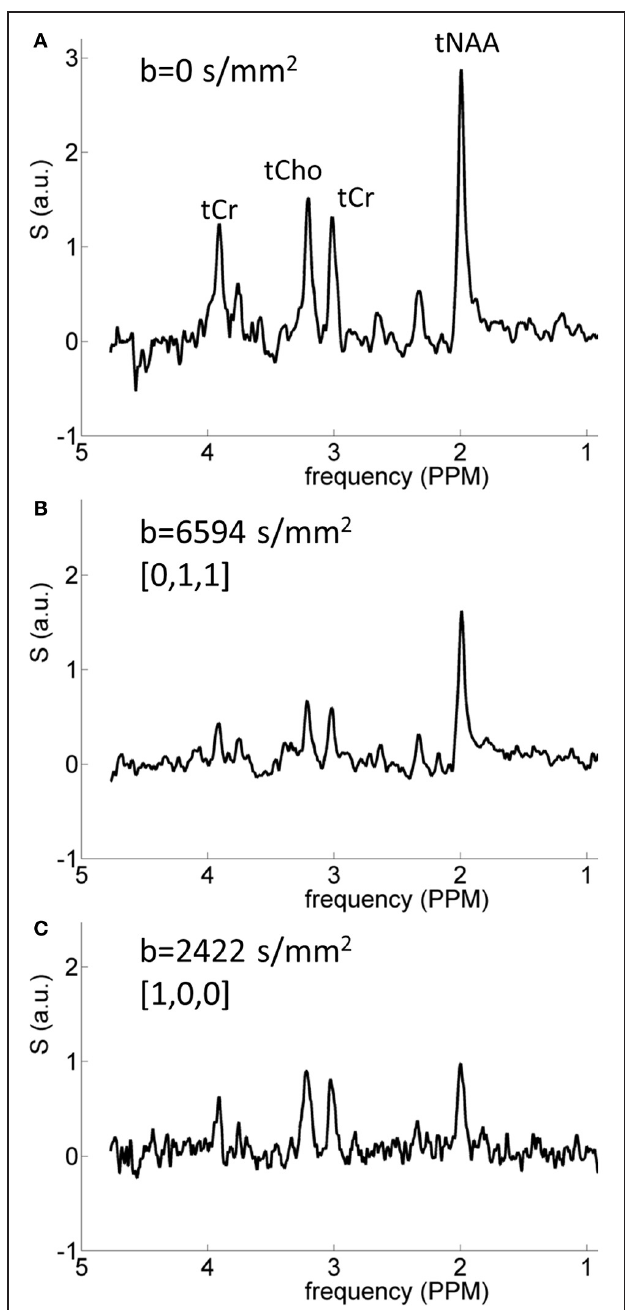
FIGURE 4 | Typical spectra acquired from one of the subjects. (A) Spectrum acquired without diffusion weighting; (B) spectrum acquired in the direction [0,1,1] with b = 6594s/mm 2 , the largest b -value used here; (C) spectrum acquired with b = 2422s/mm 2 in the direction [1,0,0]. The strong diffusional anisotropy of the tNAA signal is clearly seen.